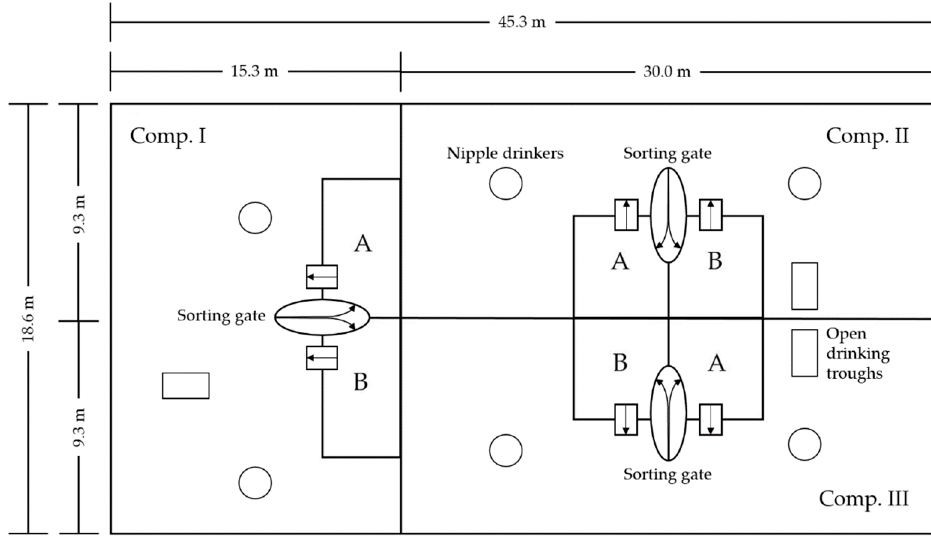
Figure 1. Outline of the experimental barn with its three compartments (Comp. I–III). Each compartment was equipped with two feeding areas ( A and B , respectively), which could be reached by the animals of each compartment via a sorting gate and left via an exit door.